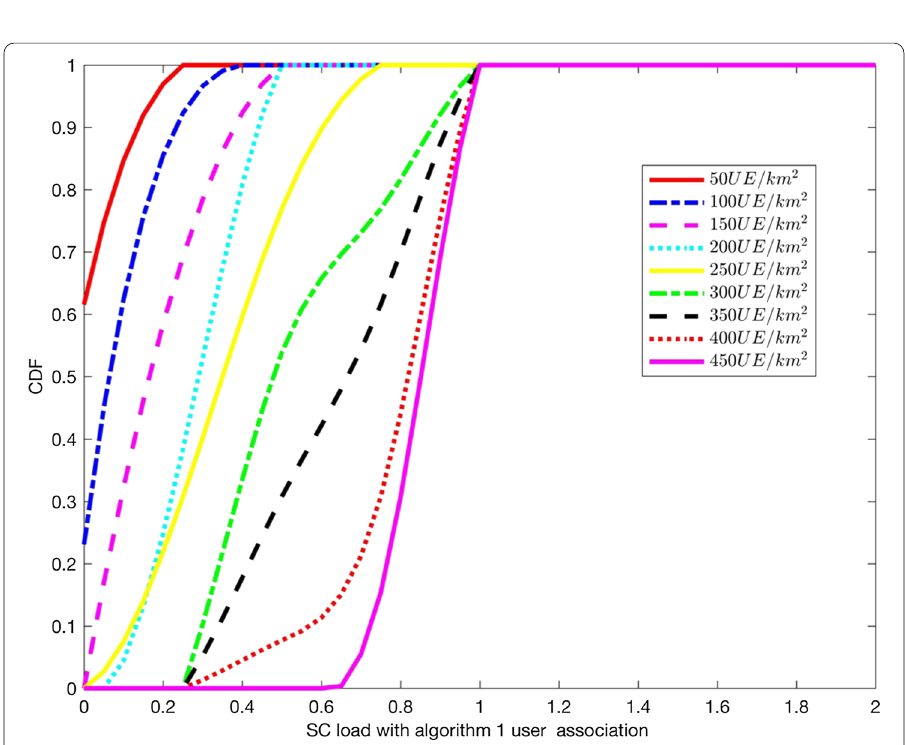
Fig. 9 SC load of algorithm 1 user association versus the different density of